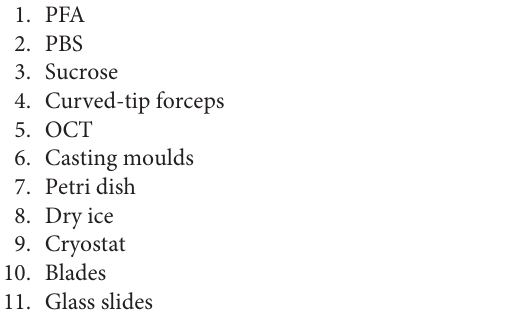
FIGURE 1 | Spheroid generation timeline. Blue, cycling cells; magenta, G1-arrested cells; dark grey, necrotic cells.